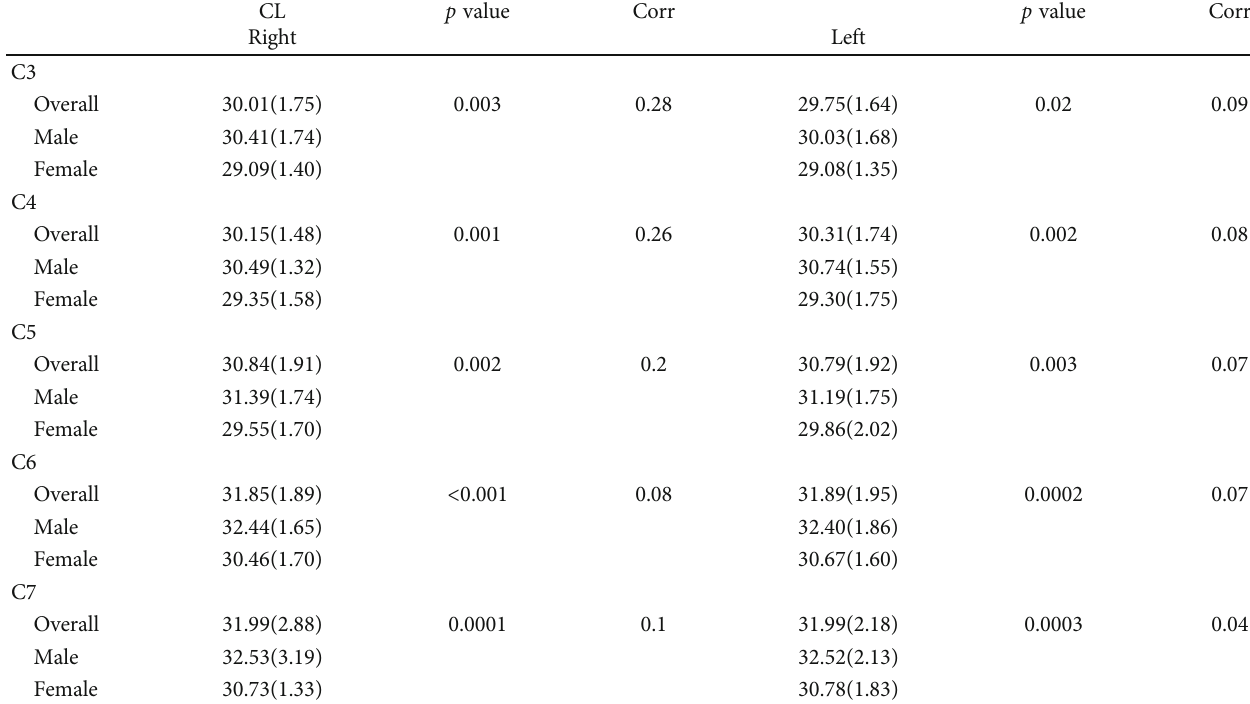
Table 2: Cord length (cl) of 70